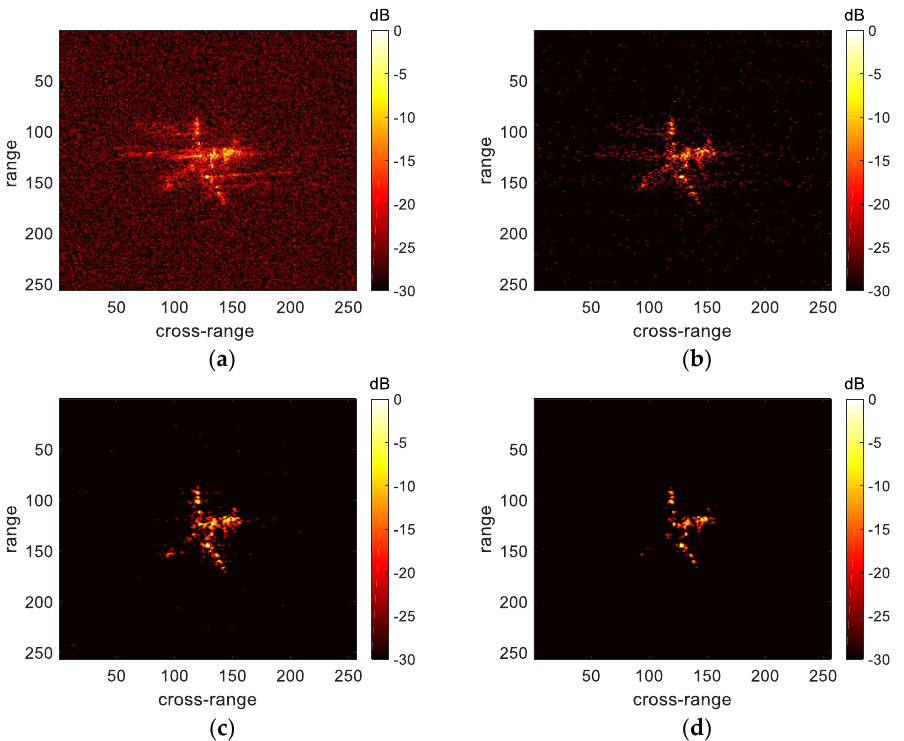
Figure 8. ISAR imaging results for Yak-42 by different methods under SNR = 0 dB: ( a ) the result of RD method; ( b ) the result of HAF–ICPF method; ( c ) the result of IPCPF–RWVD method; ( d ) the result of the proposed method.